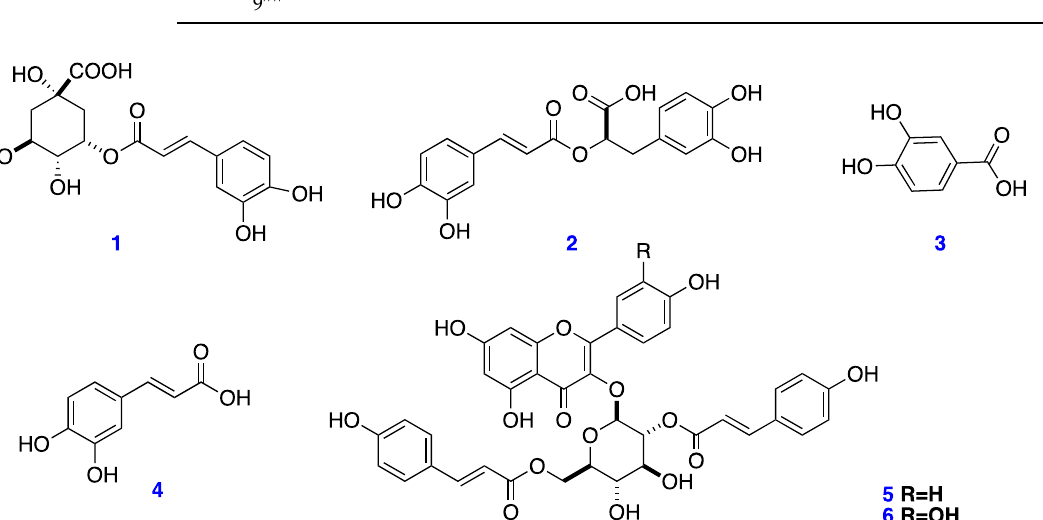
Figure 1. Compounds isolated from Eryngium cymosum. Chlorogenic acid ( 1 ); rosmarinic acid ( 2 ); protocatechuic acid ( 3 ); caffeic acid ( 4 ); kaempferol-3- O -(2,6- di - O - trans - ρ -coumaryl)- β - D -glucopyranoside ( 5 ); and quercetin-3- O -(2,6- di - O - trans - ρ -coumaryl)- β - D -glucopyranoside ( 6